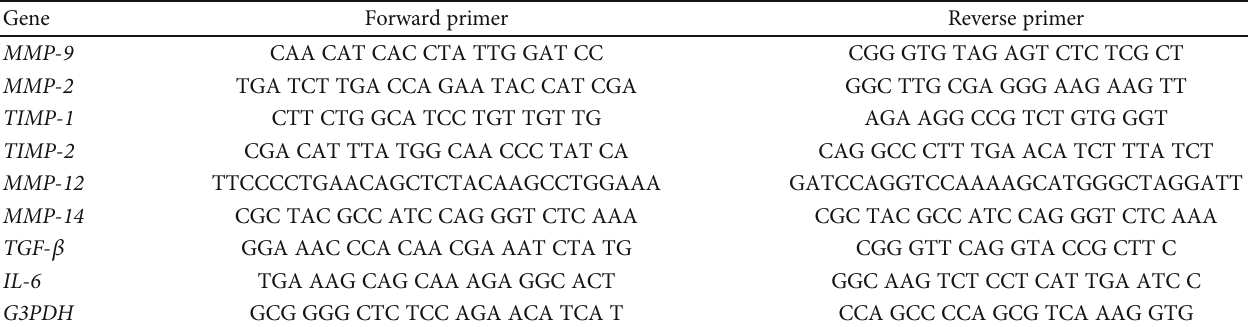
MMP - 2 , 9 , 12 , and 14 indicate matrix metalloproteinase-2, 9, 12, or 14, respectively. TIMP - 1 and 2 indicate tissue inhibitor of metalloproteinase-1 or 2. TGF - β : transforming growth factor beta; IL - 6 : interleukin-6; G3PDH : glyceraldehyde-3-phosphate dehydrogenase.